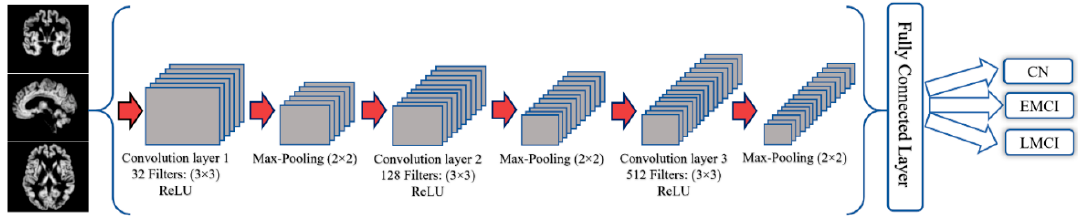
Figure 2. The architecture of the convolutional neural network.